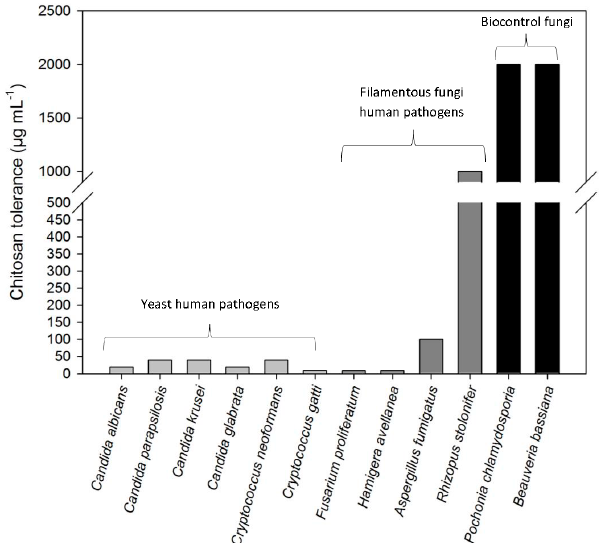
Figure 1. Filamentous fungi and yeast show large variability in chitosan sensitivity. Chitosan sensitivity is represented by the MIC ( μ g ∙ mL − 1 ) when the fungi are grown with chitosan in liquid media (unpublished and data from